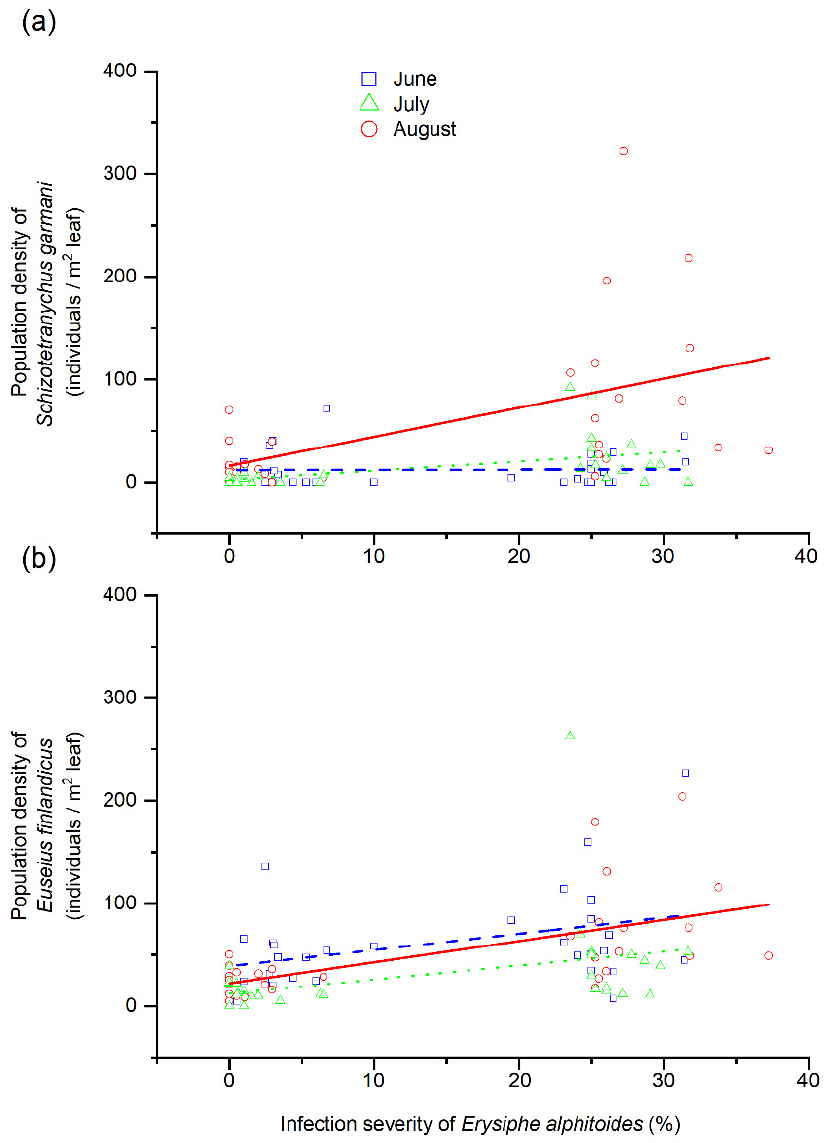
Figure 3. Relationships between severity of powdery mildew ( Erysiphe alphitoides) in Quercus robur leaves and ( a ) population density of the phytophagous mite Schizotetranychus garmani or ( b ) population density of the predatory mite Euseius finlandicus . Severity ranged from 0 to 100, corresponding to an infected leaf area percentage of 0 to 100%. Circles, squares and triangles represent mean values at the tree level for June, July and August, respectively.